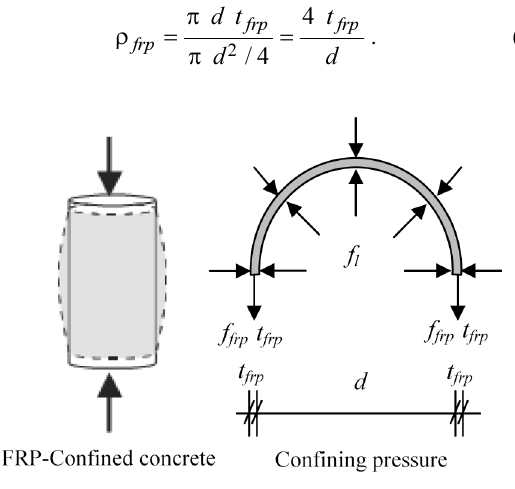
Fig. 1. Confinement action of FRP jacket in circular sections